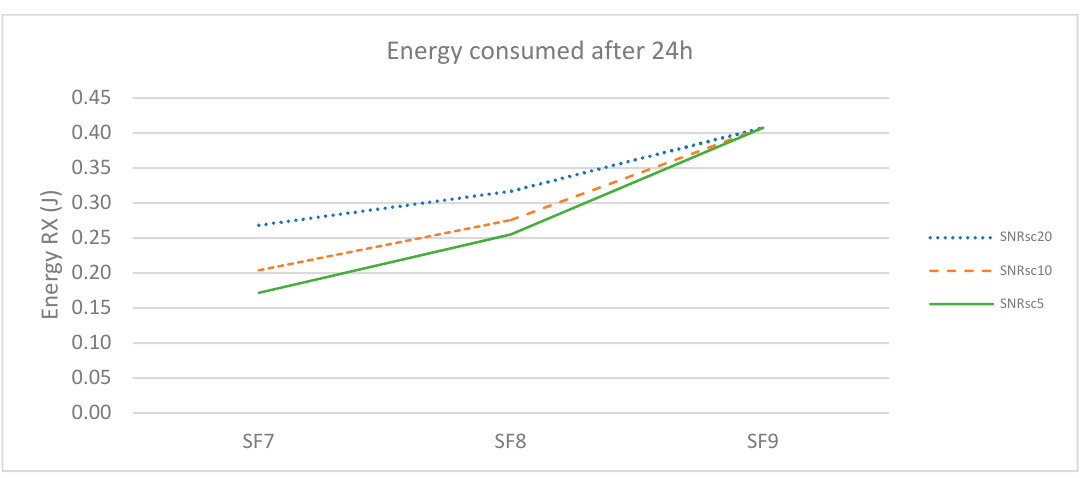
Figure 14. Total energy consumed by packet reception by EDs in the network for 24 h with downlink periodicity of 1950 s.